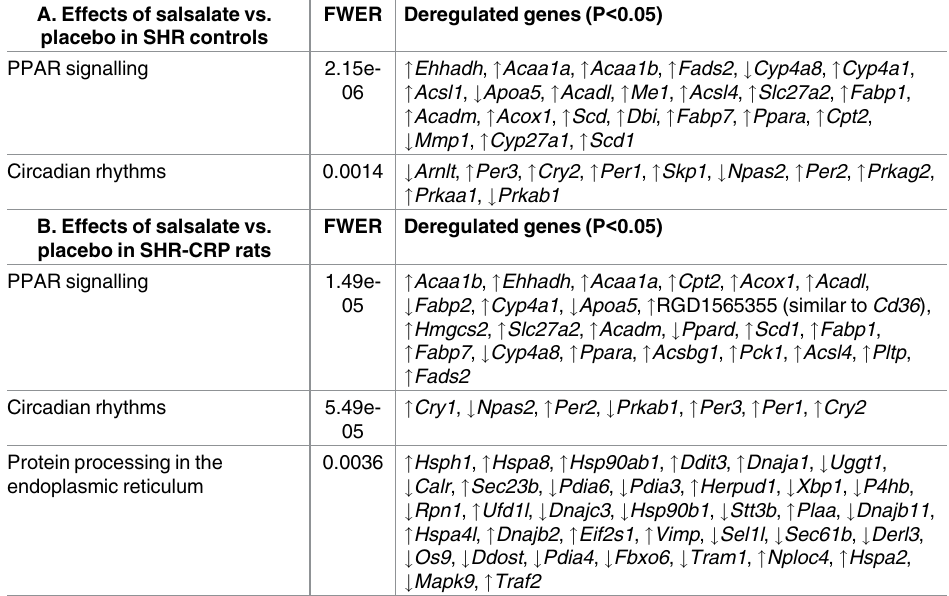
Table 3. List of genes from KEGG pathways identified by SPIA showing the effectsof salsalateversus placebo in SHR controls (A) and in SHR-CRP rats (B). A. Effects of salsalate vs. placebo in SHR